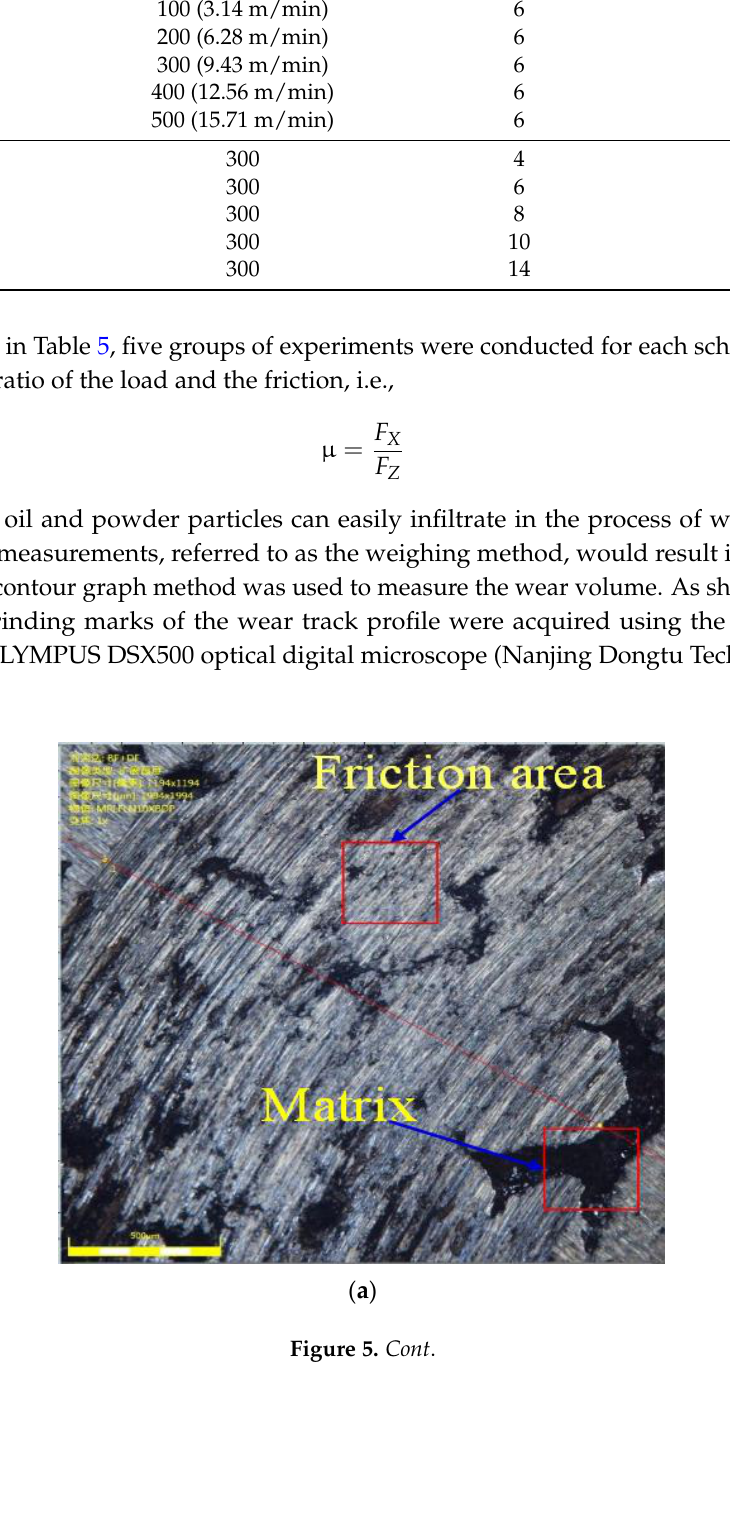
Table 5. Schemes of tests.